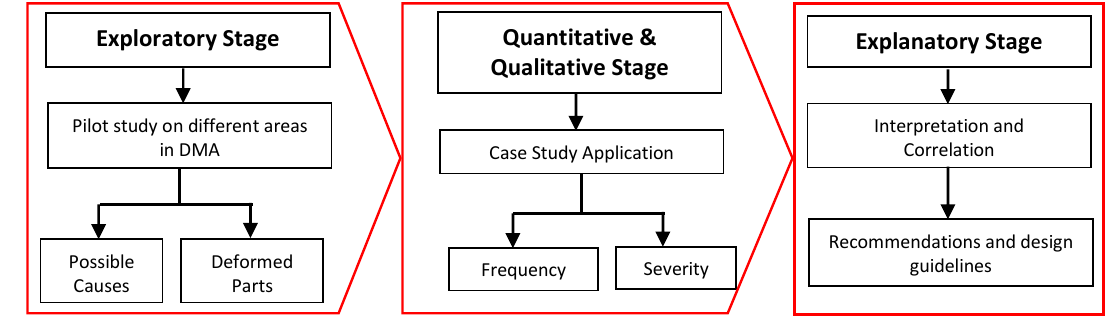
Figure 3: Methodology of investigating date palms trees‘ trunks deformation went through three stages, each with its own tasks as extended from the previous